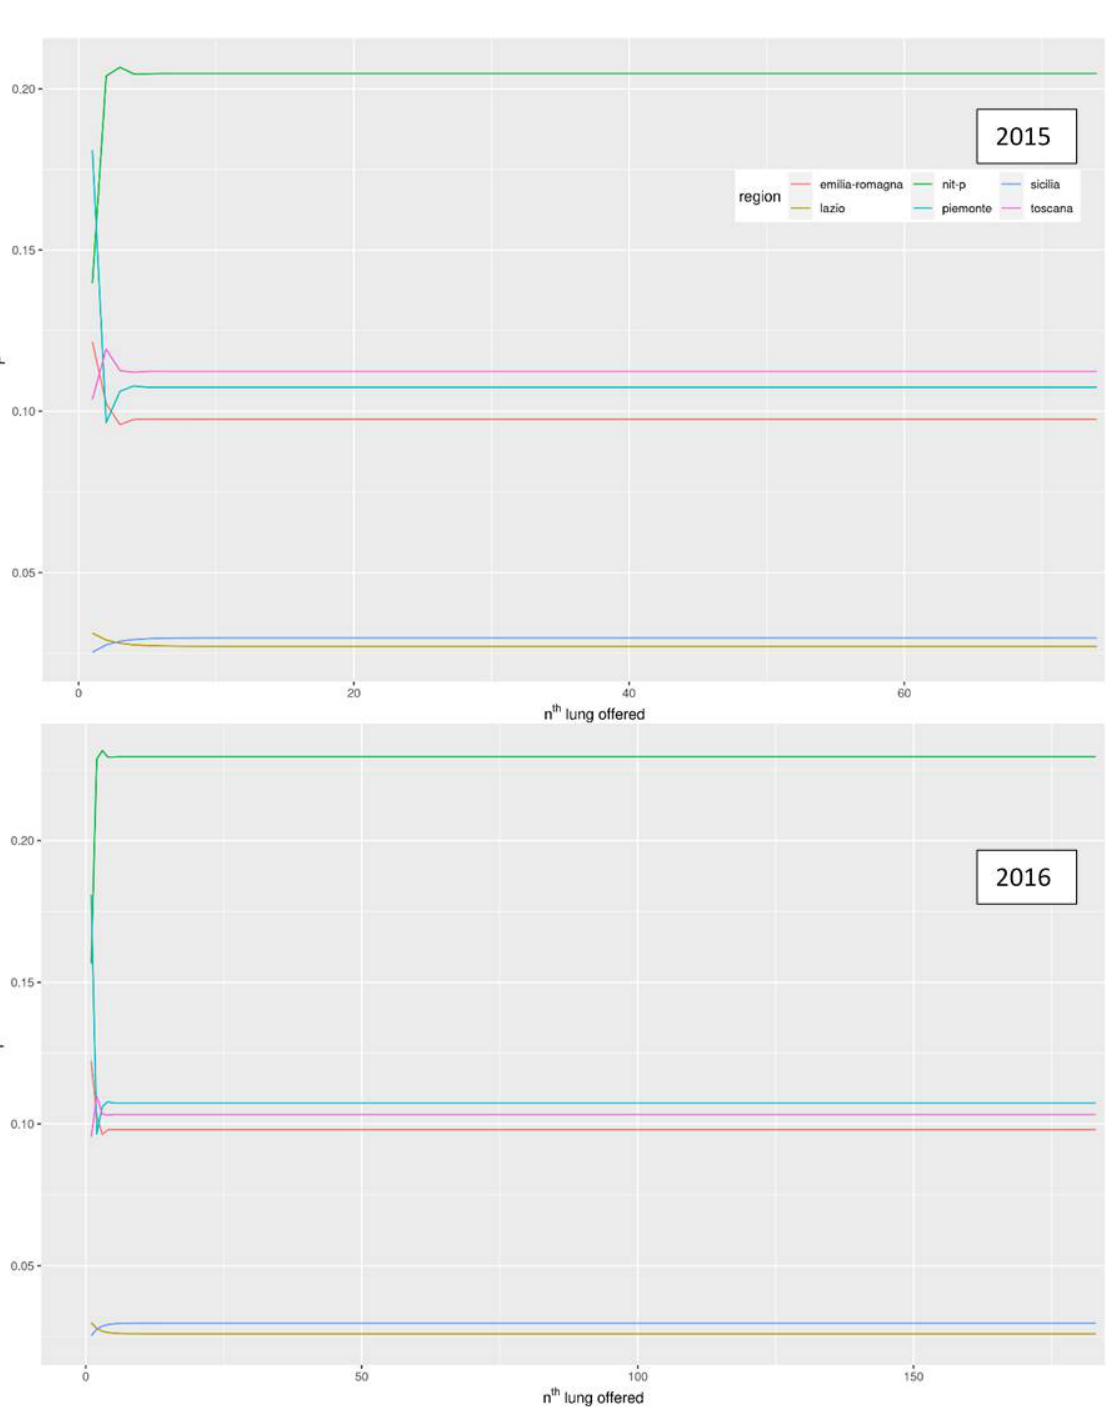
Figure 3. Trend of the probability for the n-th lung to be offered and accepted by each region as the number of lungs donated increases for the years 2015 and 2016.